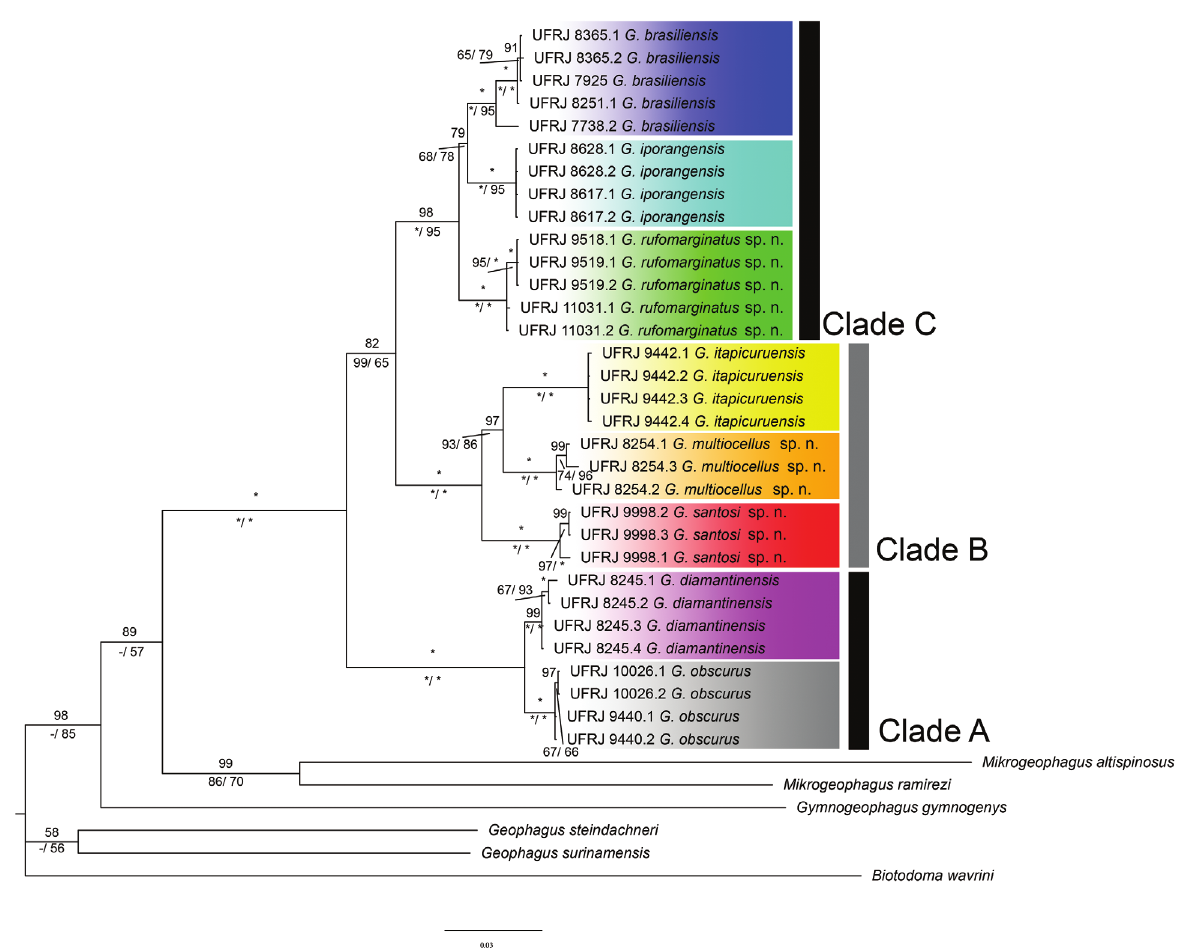
Figure 1. Tree topology estimated by Bayesian inference analysis for the ‘ Geophagus ’ brasiliensis species group. Numbers before terminal species names are voucher numbers. Numbers above branches indicates Bayesian posterior probabilities and below boot- strap values of the Maximum Parsimony and Maximum Likelihood analyses, respectively, separated by bar. Dashes indicate values below 50 and asterisks indicate maximum support